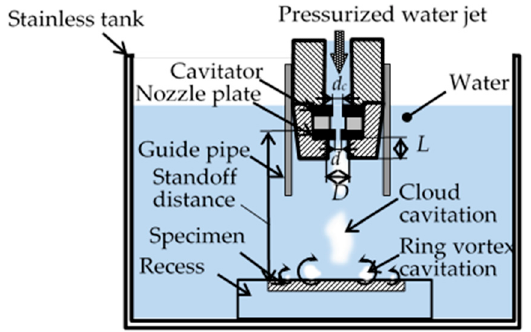
Figure 2. Schematic diagram of cavitation peening (CP) using a cavitating jet.